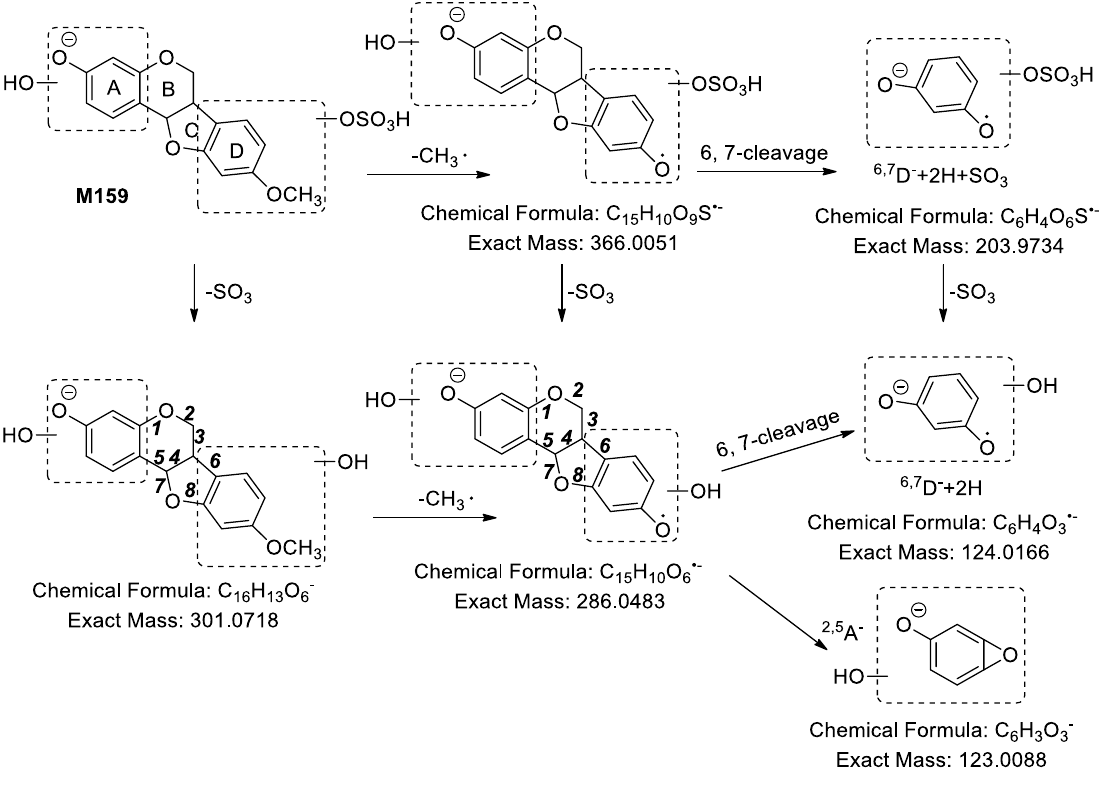
Figure 13. The proposed fragmentation pathways of M159 .